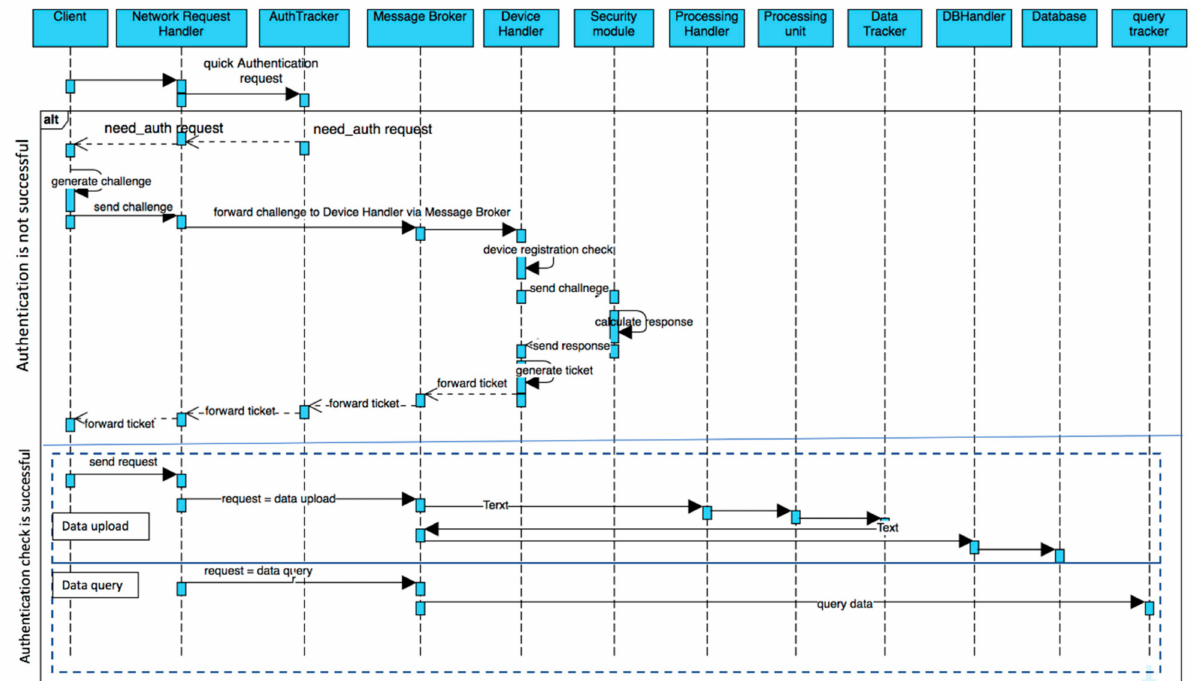
Figure 5. Internal communications between the server